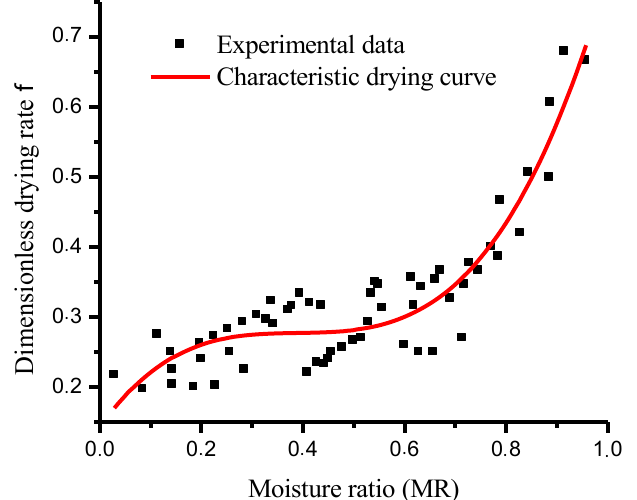
Figure 6. Dimensionless drying rate against moisture ratio of Arbutus unedo L. fruits.